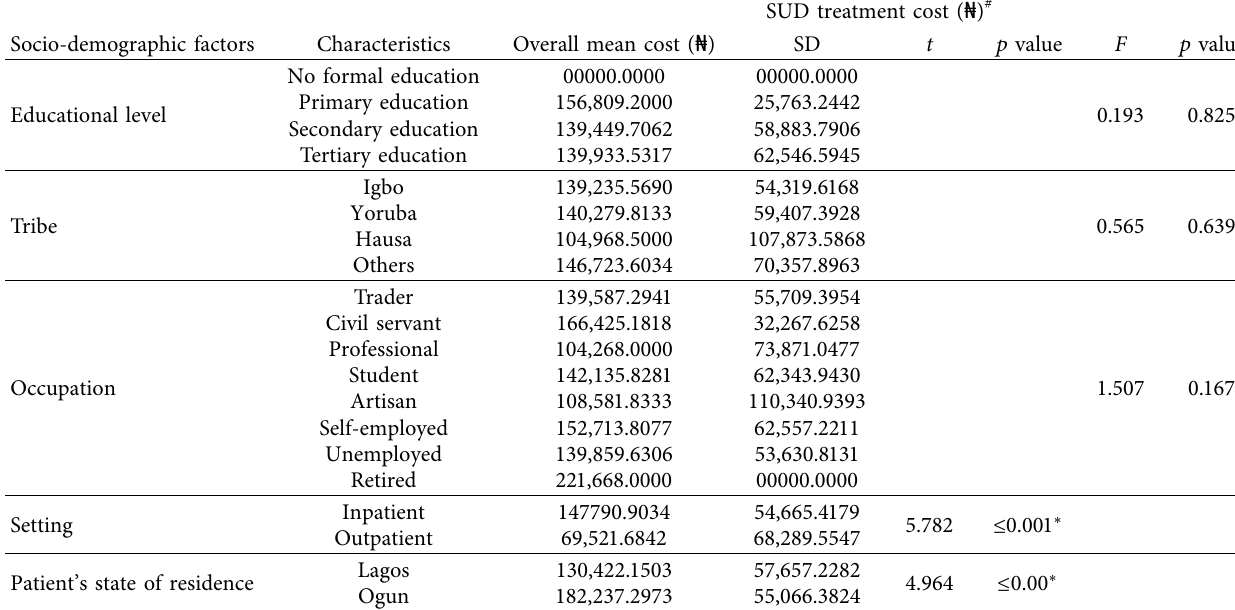
Table 5: Variation among the different categories of substance use disorders on the direct cost of treatments. Source of treatment cost